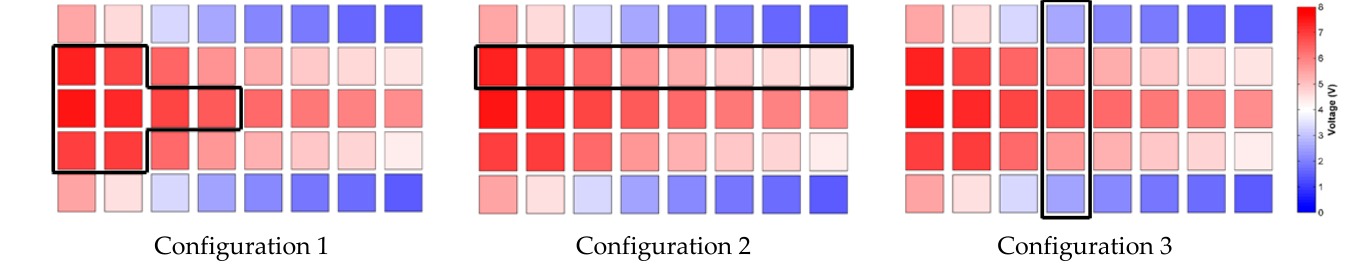
Figure 11. Connection configurations of different groups of TEMs.